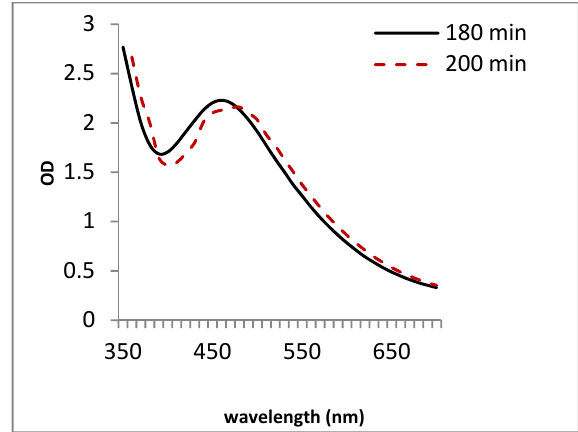
Figure 1. UV-visible absorption spectra of Ab .Ag-NPs in different